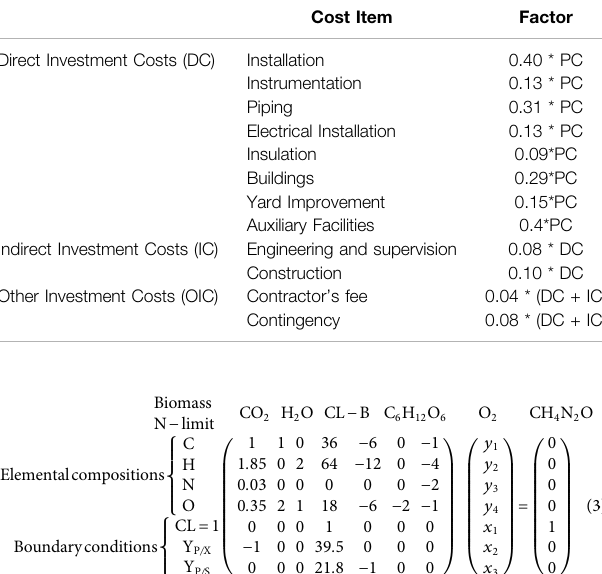
TABLE 1 | Factors applied for estimation of the direct fi xed capital investment, based on the equipment purchase cost (PC), the total direct investment costs (DC), and the indirect investment costs (IC). Calculation factors are based on (Peters and Timmerhaus